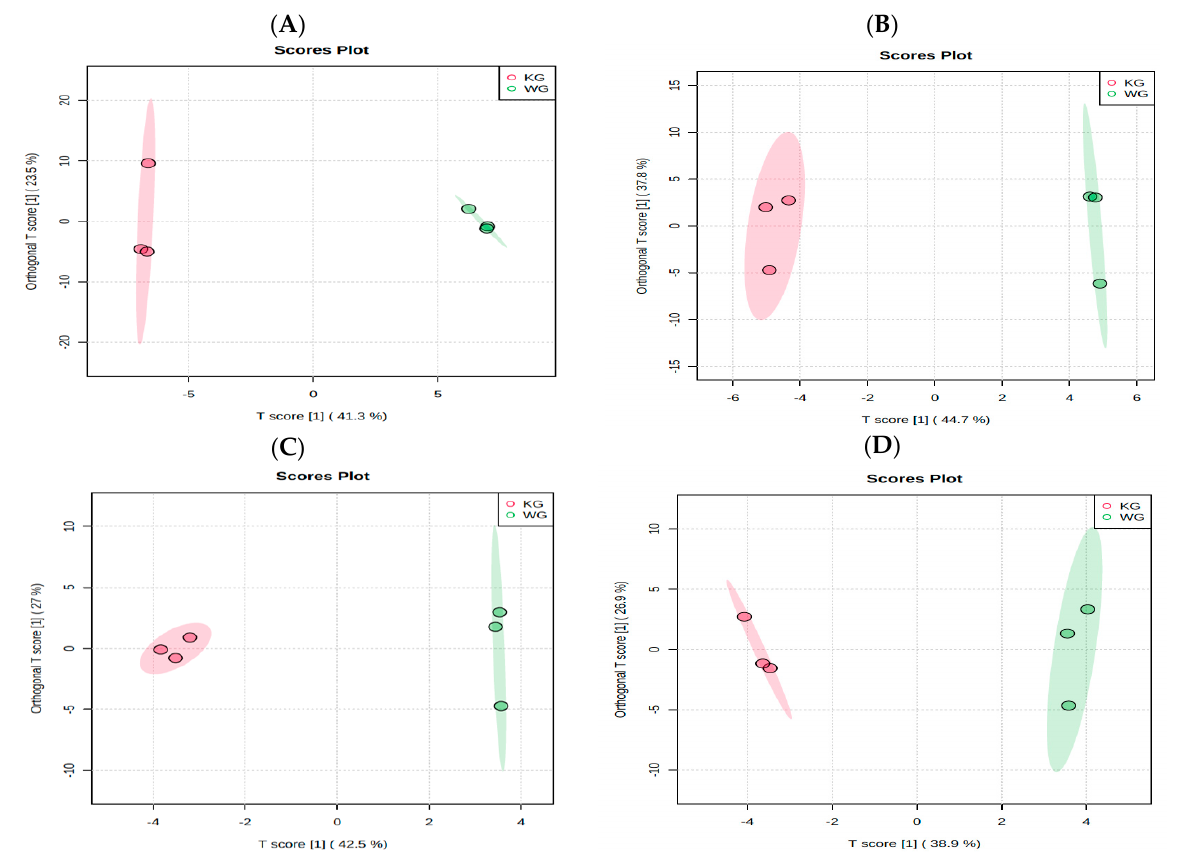
Figure 1. OPLS-DA score plots for brews of Kaua’i green (KG, n = 3) and Waialua green (WG, n = 3) coffees for known ( A ) global metabolites, ( B ) positive ESI mode lipids, ( C ) negative ESI mode lipids, and ( D ) biogenic amines.